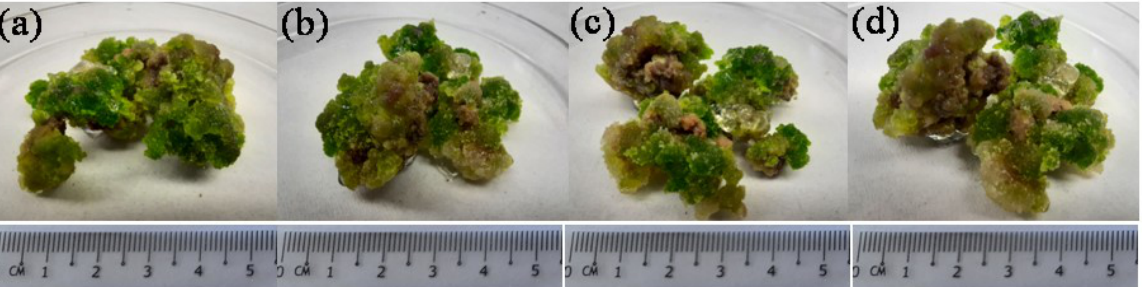
Values denote the mean of three replications per treatment ± SE (standard error). Mean values with the same letters are not significantly different based on the Student’s t- test at p = 0.05 . The lowest average survivability was also found using 5% of Clorox for 5 min (16.67%), 10% of Clorox for 5 min (22.22%), 20% of Clorox for 10 min (22.22%), 20% of Clorox for 15 min (16.67%), and 30% of Clorox for 5 min (22.22%) (Table 8). The MS media in which PGRs were not included showed no compact callus induction 3.2. Callus Induction from the cultured explants of stevia at 30 DACI. The MS media supplemented with and The leaf segments of stevia were utilized as explants for the induction of callus on 0.10 mg/L zeatin and different concentrations of 2,4-D (0.10 mg/L, 0.25 mg/L, 0.50 mg/L, MS media supplemented with different concentrations of 2,4-D and 0.10 mg/L zeatin. The 0.75 mg/L, 1.00 mg/L, and 2.00 mg/L) induced 13.33, 10, 36.67, 33.33, 33.33, and 26.67% of induced calli were characterized as compact and friable calli. Figure 2 illustrates the in- duced calli from stevia explants. compact calli at 30 DACI, respectively (Figure 3a).